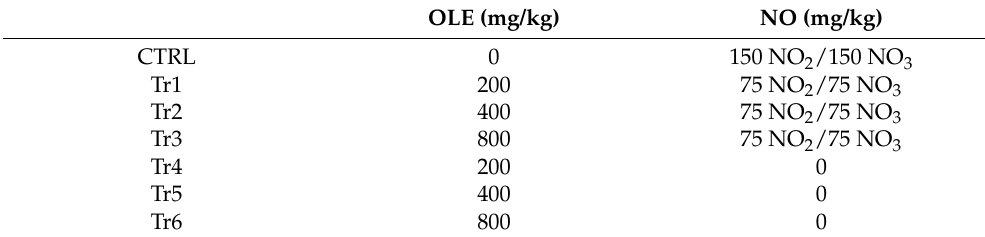
Table 1. Formulations of OLE—NO used for samples